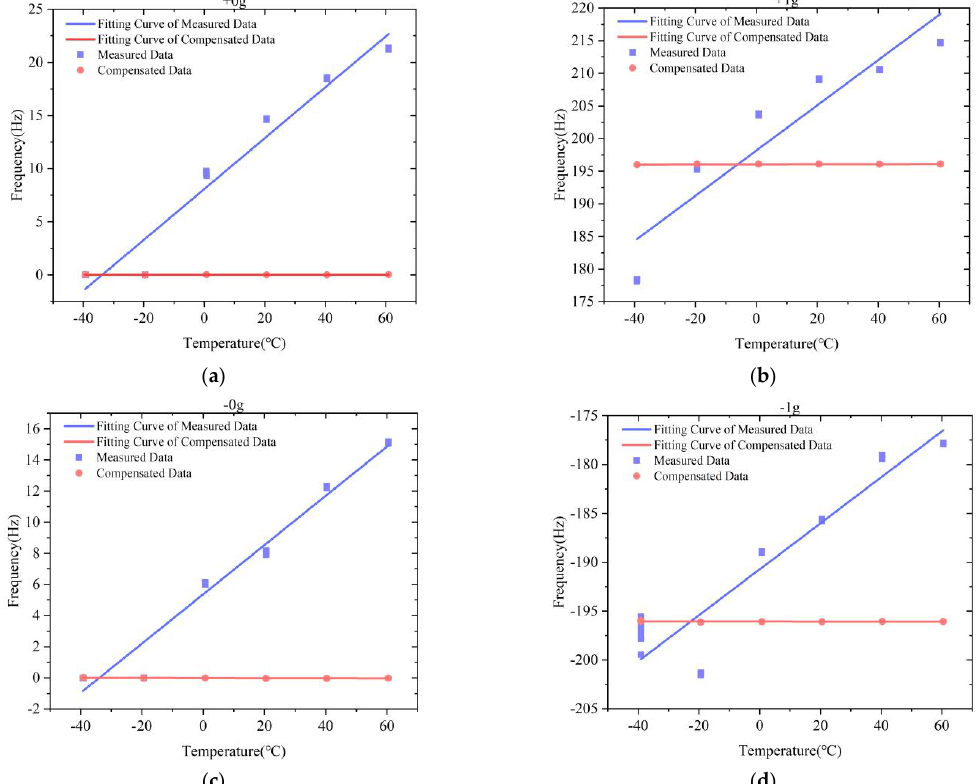
Figure 9. The IFA-BP compensation results of test dataset 1 in the full-temperature experiment: ( a ) +0 g; ( b ) +1 g; ( c ) −0 g; ( d ) −1 g.